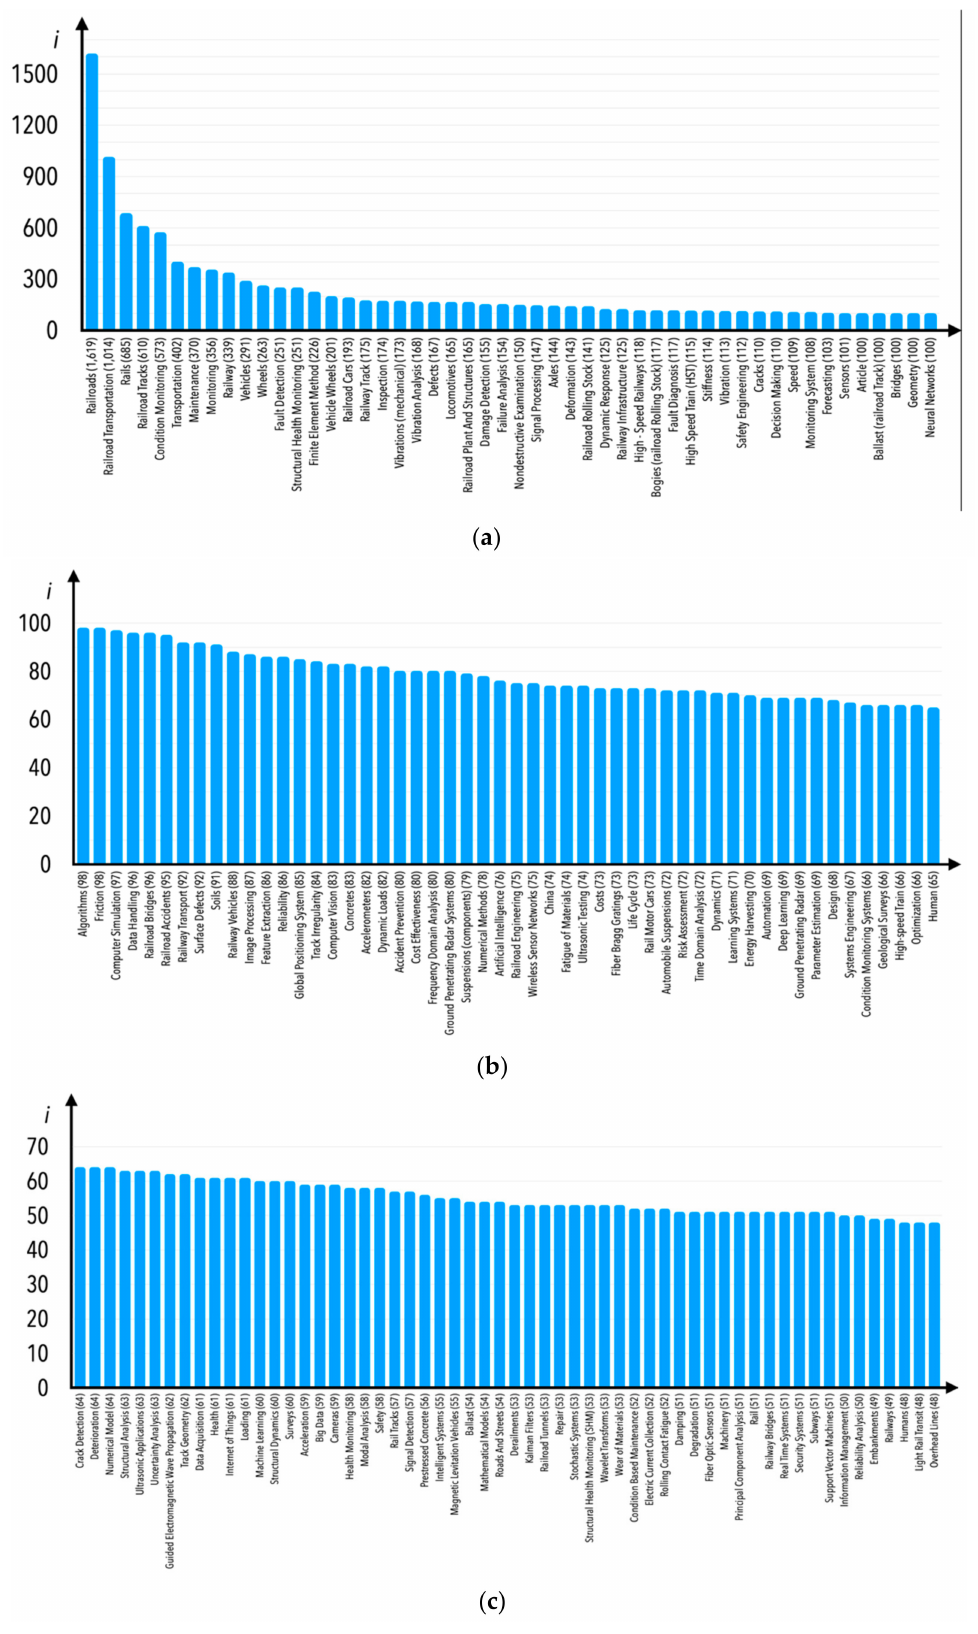
Figure 6. Number of publications ( i ) in the research area of railway transport condition monitoring per particular Scopus internal keywords: a number of publications assigned to internal keywords equal to between 0 and 64 ( c ), between 65 and 99 ( b ), and over 100 ( a